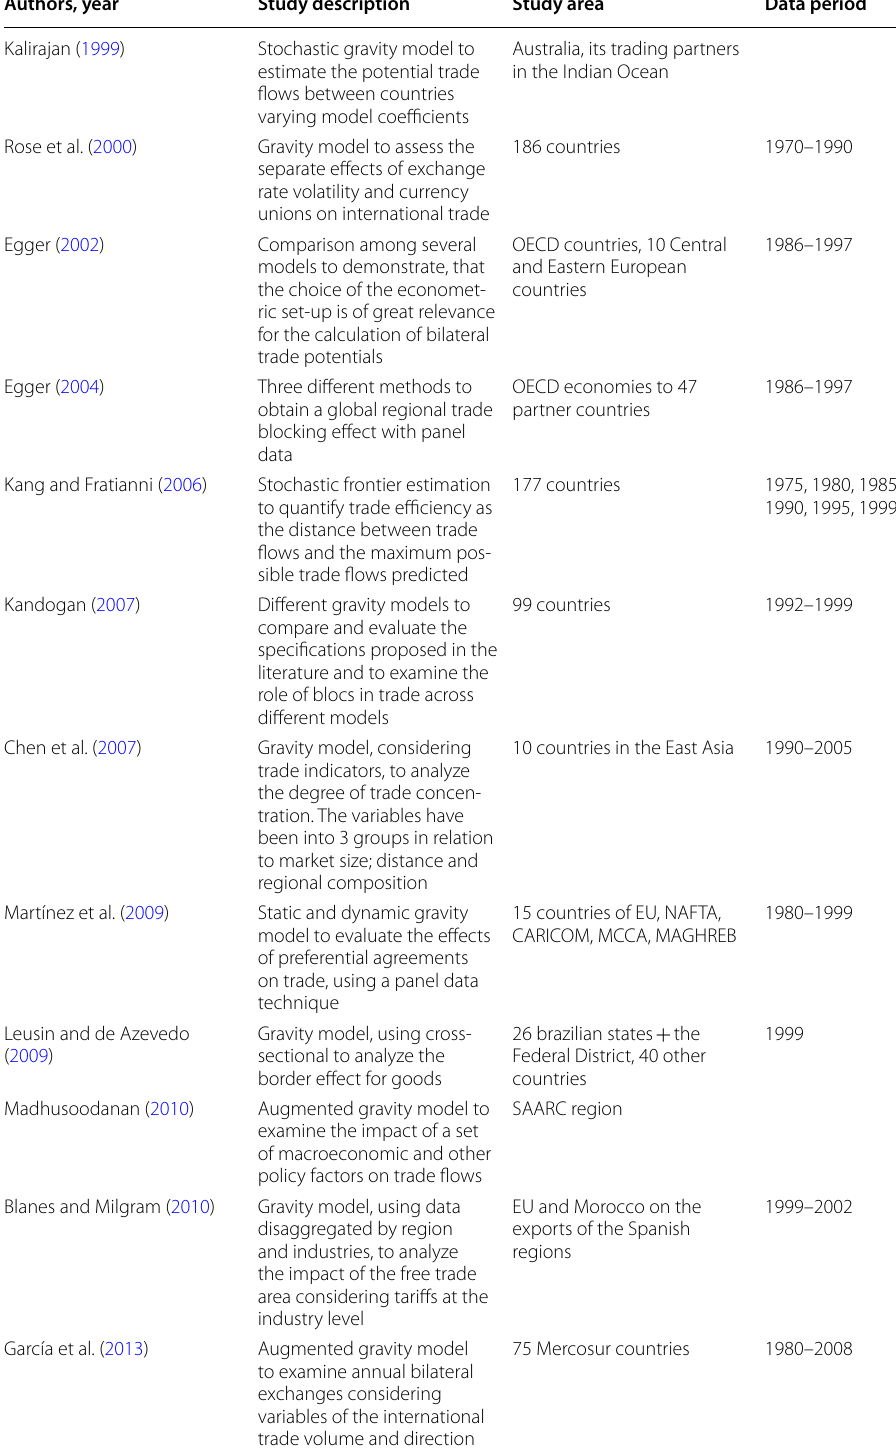
Table 1 Gravity models for freight flows